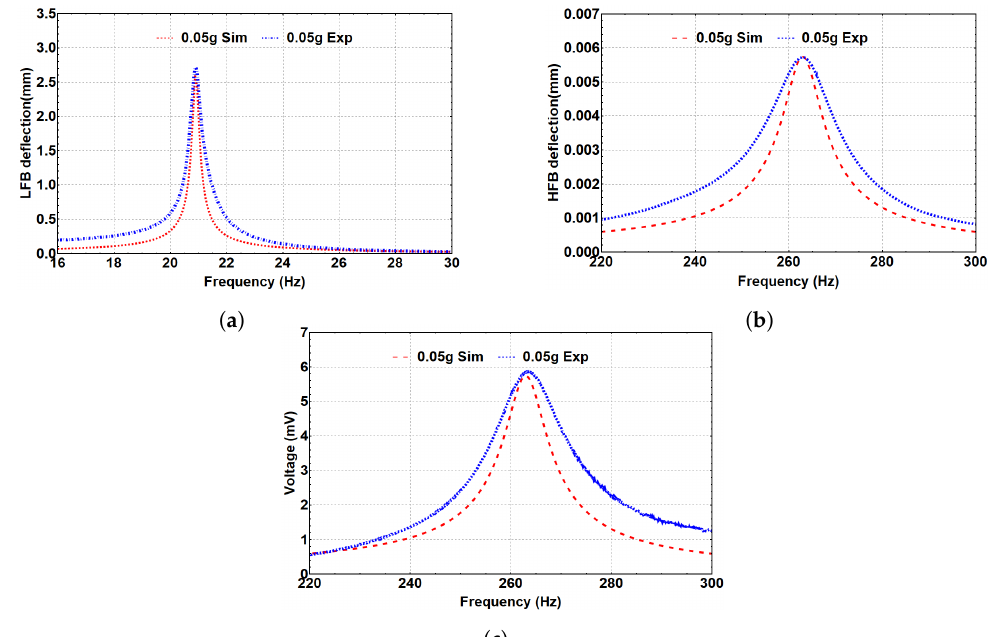
Figure 6. ( a ) Frequency response curve of the LFB. ( b ) Frequency response curve of the HFB. ( c ) Frequency–voltage curve of the HFB. The excitation level is 0.05 g.